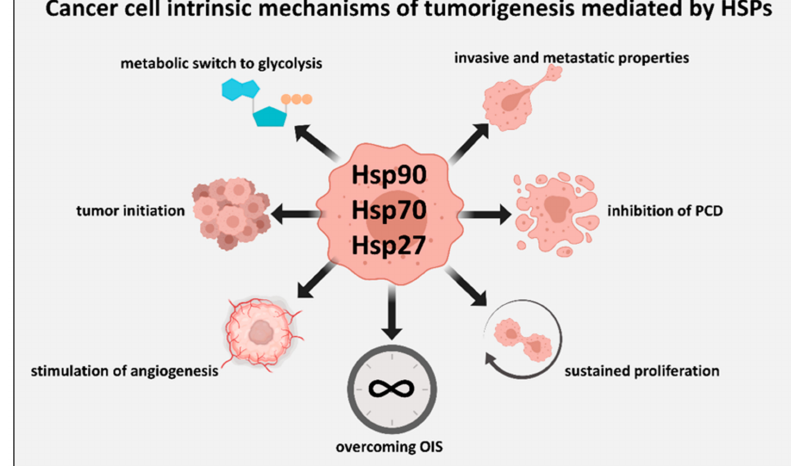
Figure 4. An overview of cancer cell-autonomous processes mediated by Hsp27, Hsp70, and Hsp90 that promote tumorigenesis. The transforming potential of cancer cell-autonomous events such as oncogenic mutations is commonly dependent on support from intracellular Hsp27, Hsp70, and Hsp90. The activities of key intracellular mitogenic signal transducers are also dependent on intracellular HSPs for sustained pathway activation, and thus HSPs mediate how cancer cells respond to the growth signals emanating from the tumor microenvironment. Similarly, signals from the tumor microenvironment can promote tumor-initiating properties within the carcinoma cells, the molecular features of which have also been closely linked with subpopulations enriched for Hsp72 and Hsf1. Such transforming events require the ability of tumor cells to overcome senescence (oncogene induced senescence—OIS), and the Hsp72 expression is required to overcome this hurdle to tumorigenesis. We also represent here other key tumorigenic processes supported by intracellular HSPs, including the inhibition of programmed cell death (PCD), altered cellular metabolism to favor glycolysis, stimulation of angiogenesis by cancer cells, and invasive and metastatic